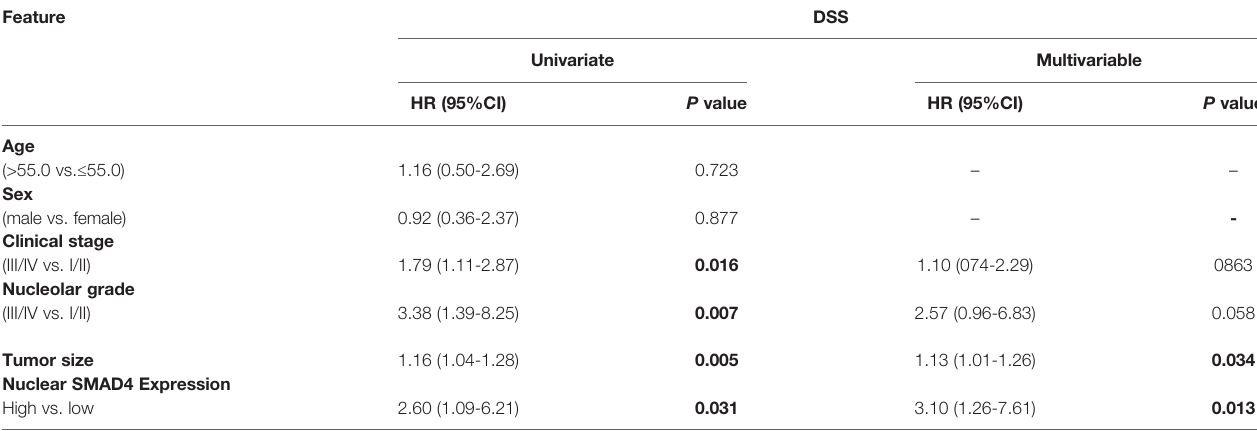
TABLE 1 | Univariate and multivariable analysis of disease free survival (DSS) and progression-free survival (PFS) in patients with renal cell carcinoma (RCC).